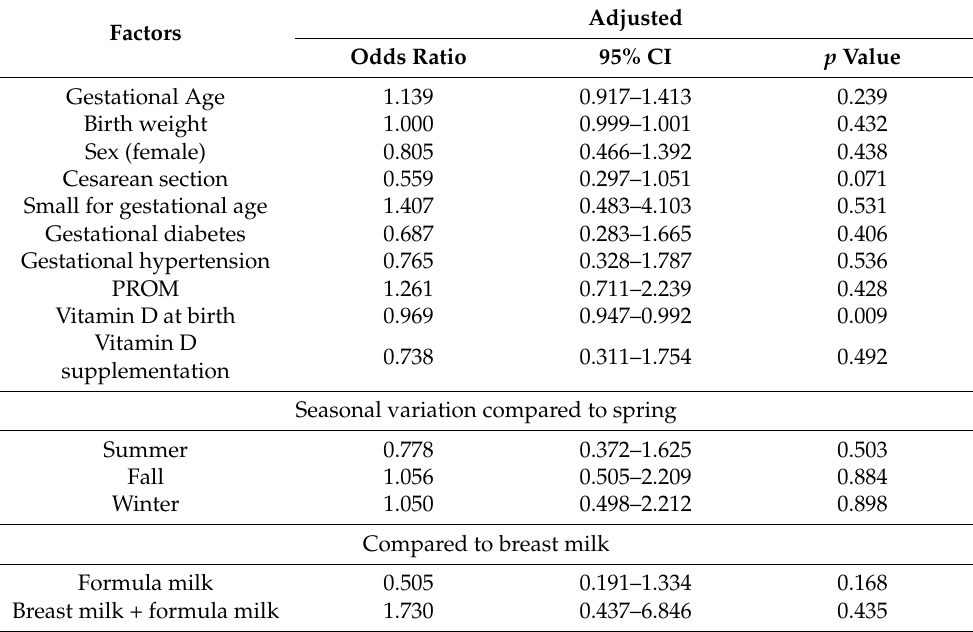
Table 5. Risk factors for vitamin D deficiency at 12 months after birth in preterm